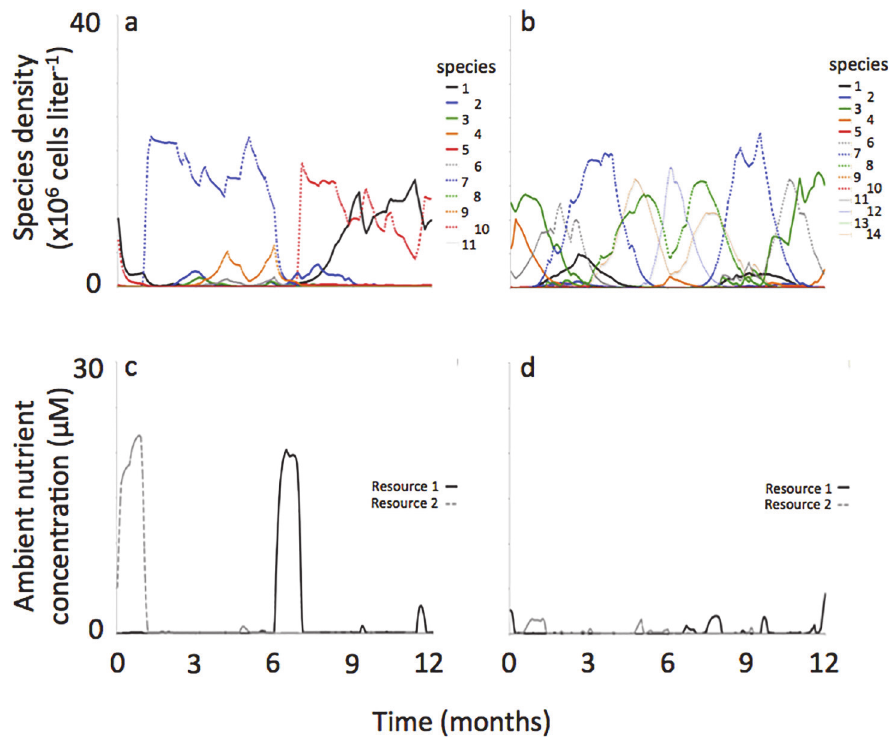
Fig 6. Representative phytoplankton population dynamics and ambient resource concentrations when reversals in the resource supply concentrations were sudden (a, c) and gradual (b, d). In these simulations there was 0 – 20% noise applied to the resource supply. Values of k S and Q S for phytoplankton populations are provided in Table